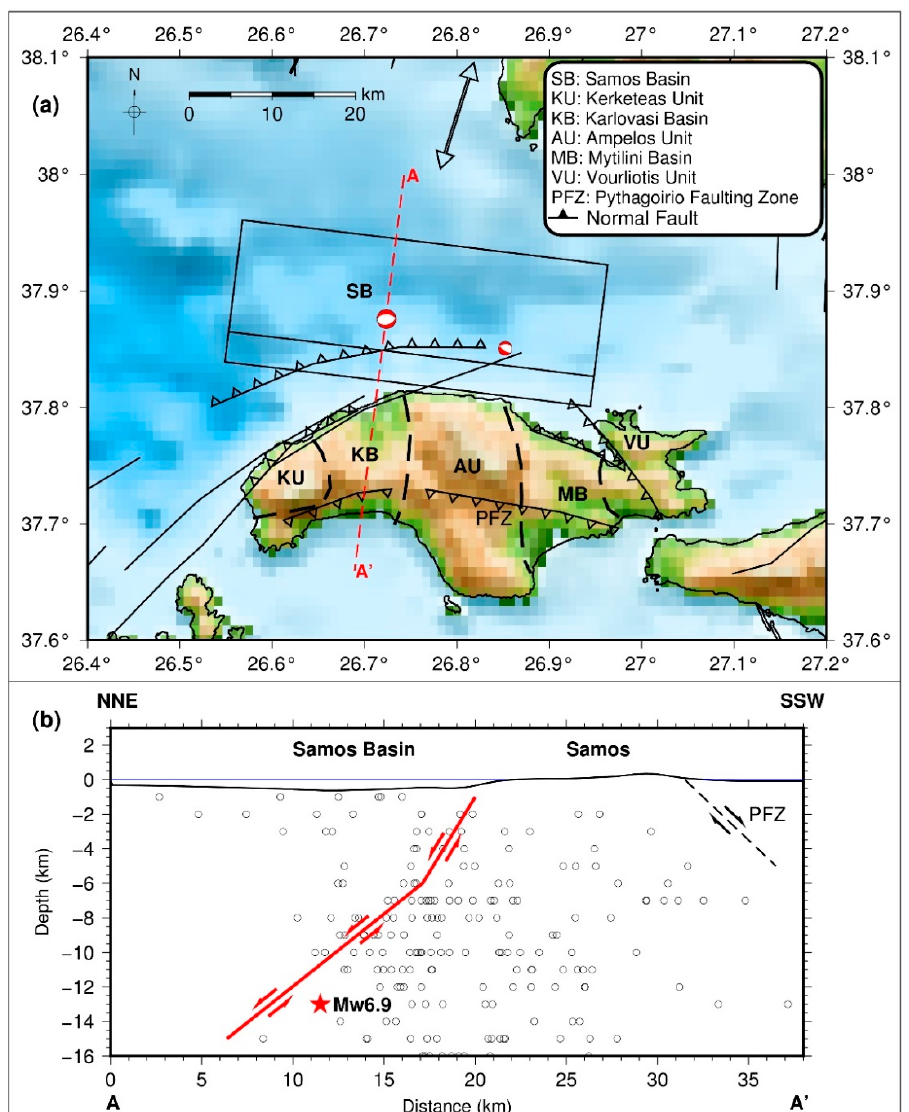
Figure 12. ( a ) Map of Samos Island showing the modelled fault plane that has been projected to the surface (black rectangle). Dashed lines delineate the main geotectonic units. The double headed arrow shows the direction of the pre-seismic, regional, extensional strain tensor. ( b ) Cross section along the AA’ line showing the modelled plane of the listric fault, which dips to the north (red line). The black circles represent the aftershocks (M ≥ 3) and their primary association with the lower fault